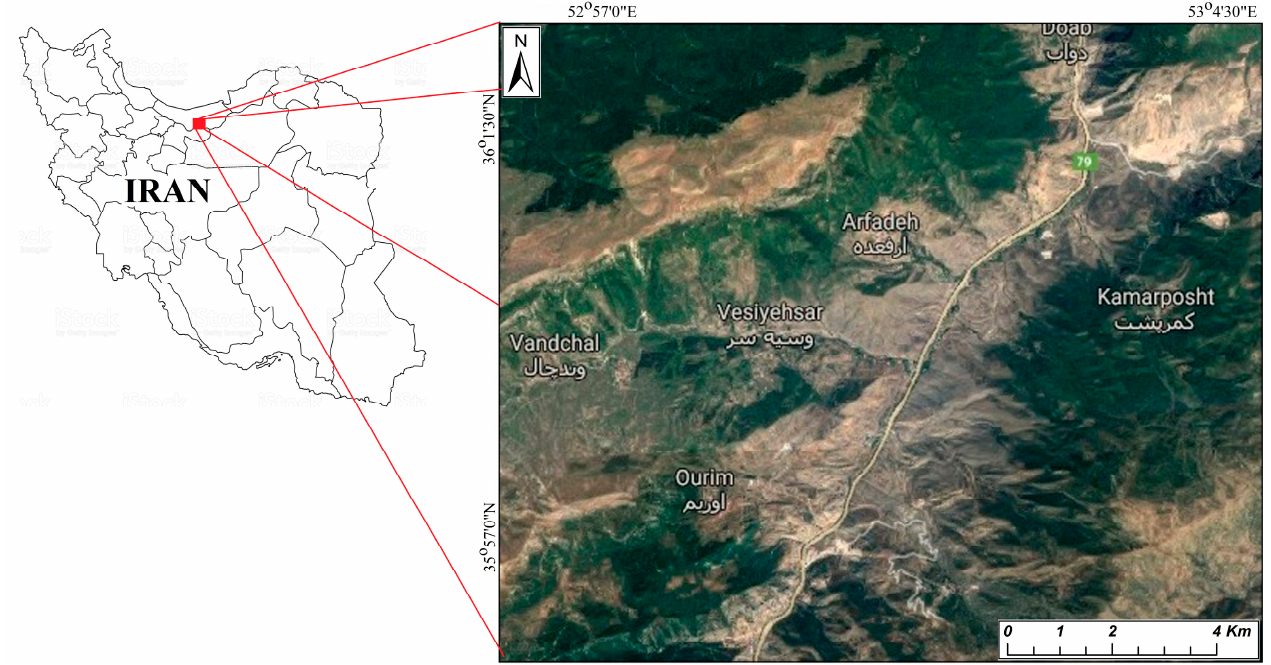
Figure 1. Location of the Gorzineh-khil region (studied area) in Iran by Google Earth.